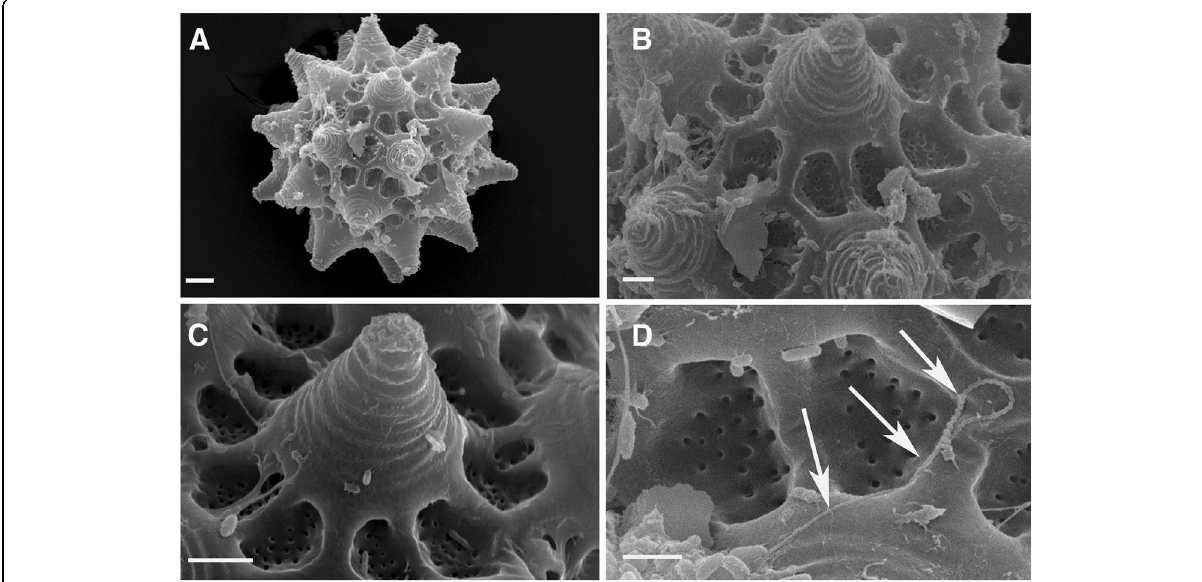
Fig. 9 Eggs of Paramacrobiotus richtersi (SEM). a In toto . b Egg processes. c Egg process with areolae at the base. d Spermatozoon (arrows) on the egg shell. Bars: a = 10 μ m, b and c = 5 μ m, d = 2 μ